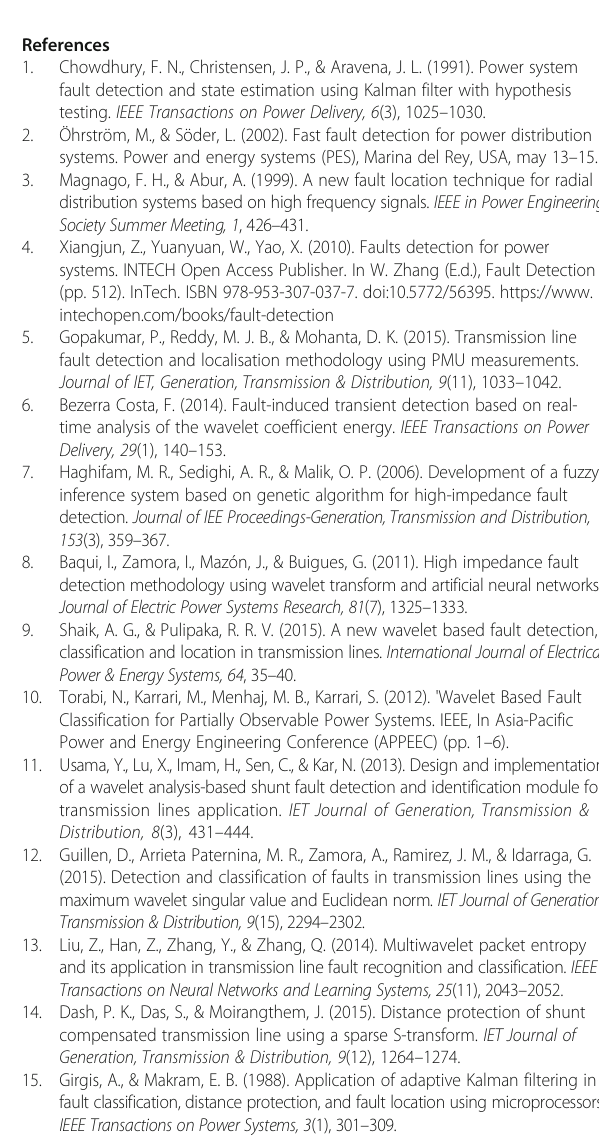
Proposed technique